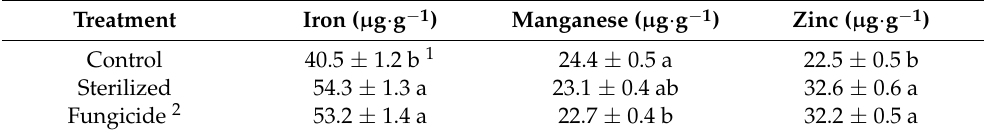
Table 8. The influence of growing Serianthes grandiflora , Serianthes kanehirae , and Serianthes nelsonii plants in soil obtained from Serianthes grandiflora rhizosphere on leaf micronutrient content. Mean ± SE, n = 18. Treatment